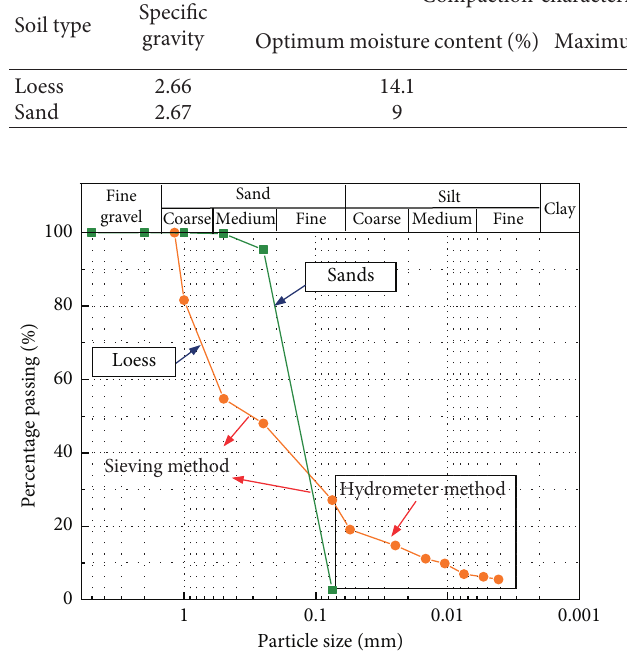
Figure 2: Grain size distributions for test soils.